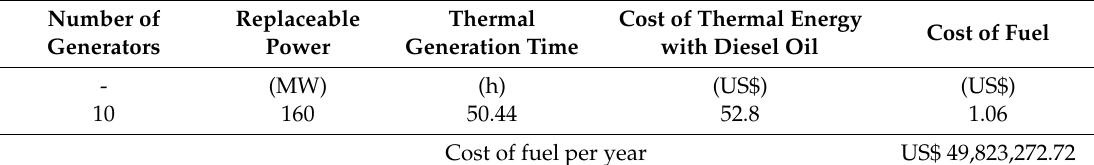
Table 11. Cost of thermal generation per year with